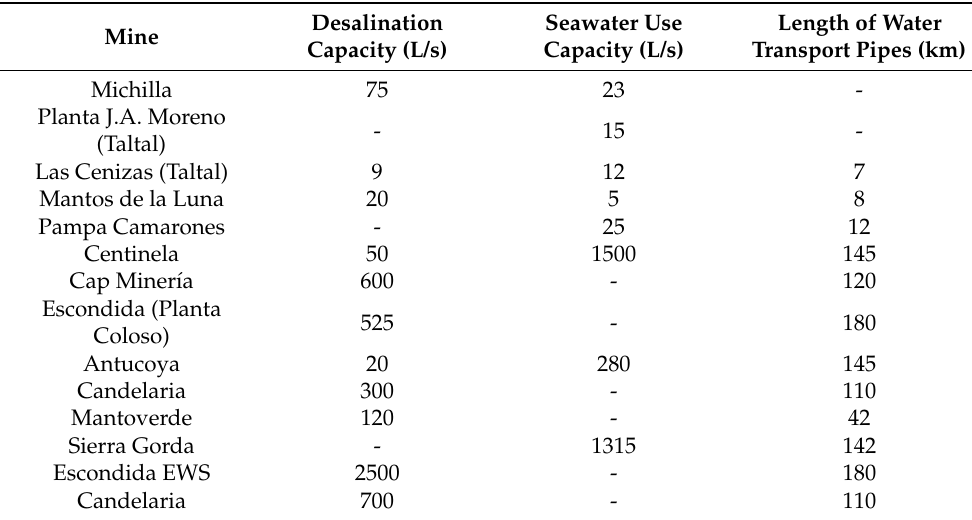
Table 3. Land registry of desalination plants and seawater impulsion systems in copper mining in operation (Data from: [59]).